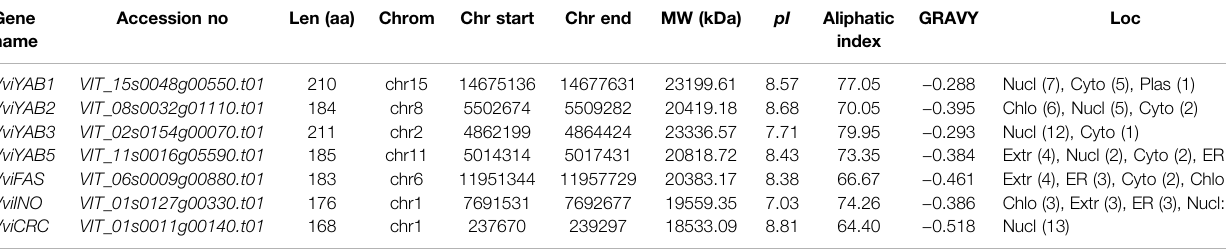
TABLE 1 | Structural and biochemical information of identi fi ed VviYABs in grapevine.